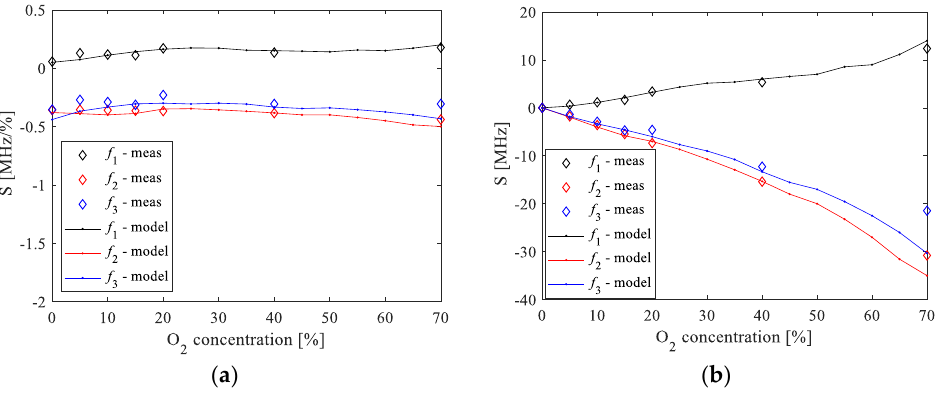
Figure 15. Comparison between measurements (symbols) and ANN simulations (lines) of the ( a ) absolute-absolute sensitivity and ( b ) absolute-relative sensitivity of the resonant frequencies to variations in the O 2 concentration. The used reference value of the O 2 concentration is 100%.